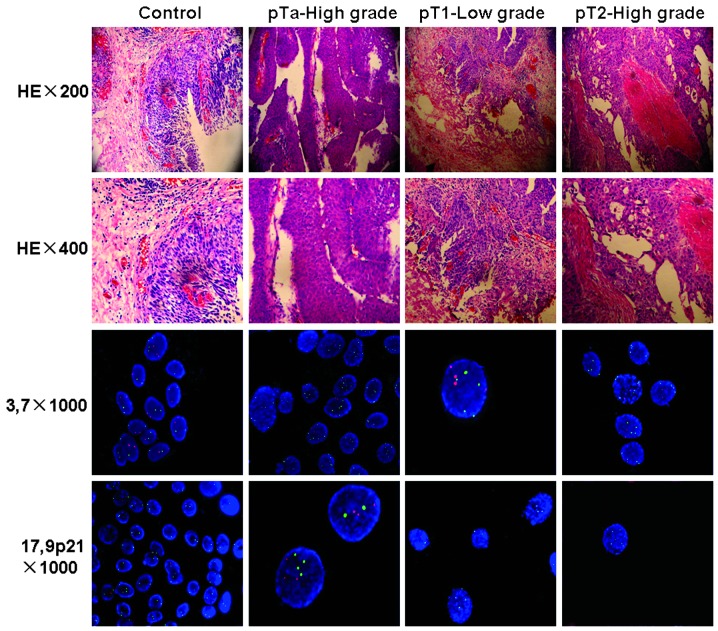
Representative images of histological findings and their corresponding FISH signal patterns for chromosomes 3, 7 and 17 and the 9p21 locus from patients with bladder inflammation (control group) and various tumor stages of bladder cancer (pTa, pT1 and pT2). Red signal represents chromosome 7 or the 9p21 locus and a green signal represents chromosomes 3 or 17. FISH, fluorescence in situ hybridization.